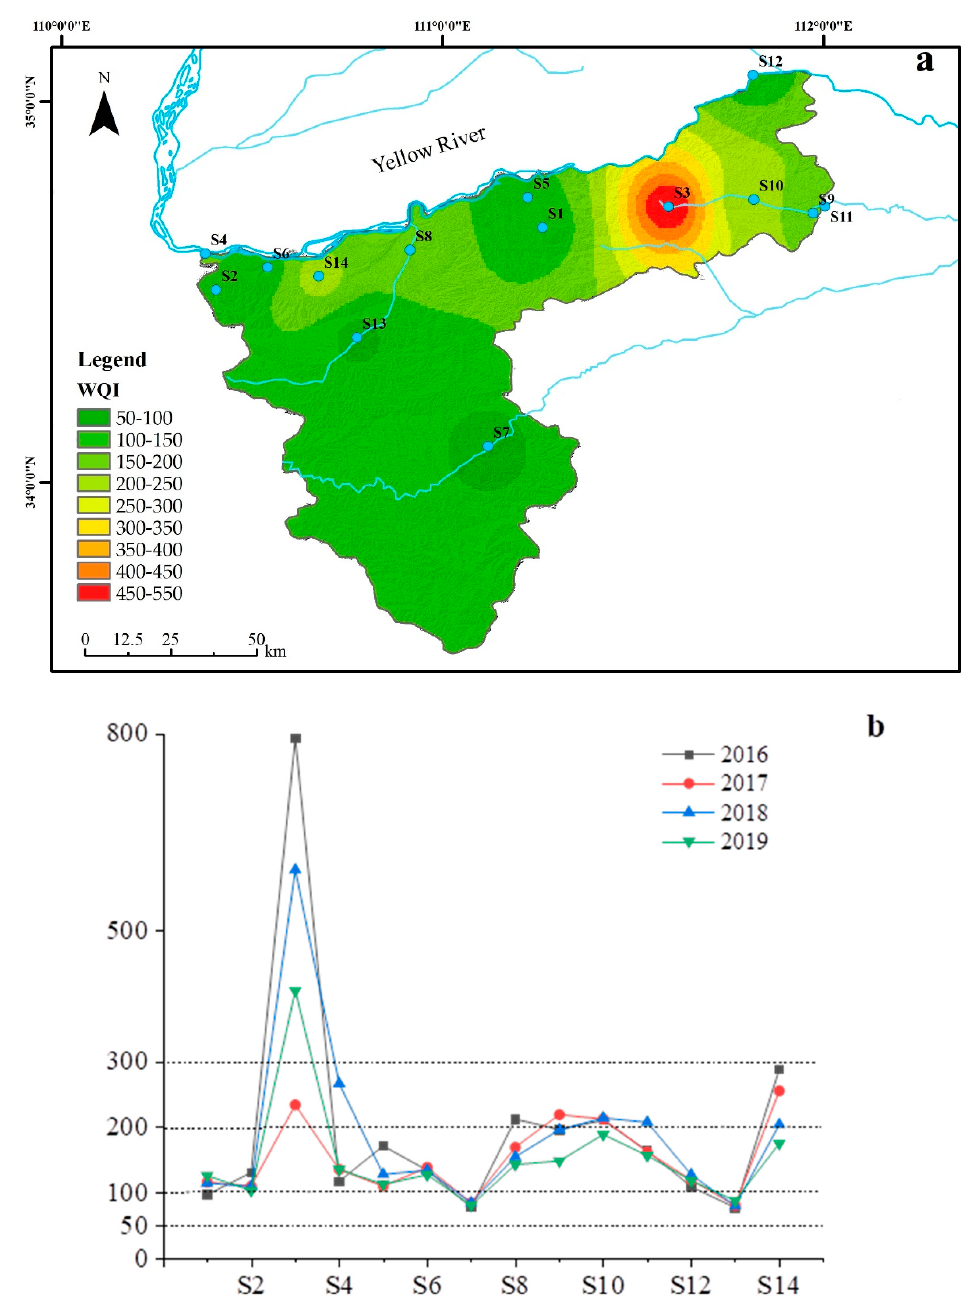
Figure 4. Spatial distribution of WQI values and variation in WQI values of sampling sites from 2016 to 2019. ( a ) distribution of WQI values; ( b ) Range variation of WQI values.